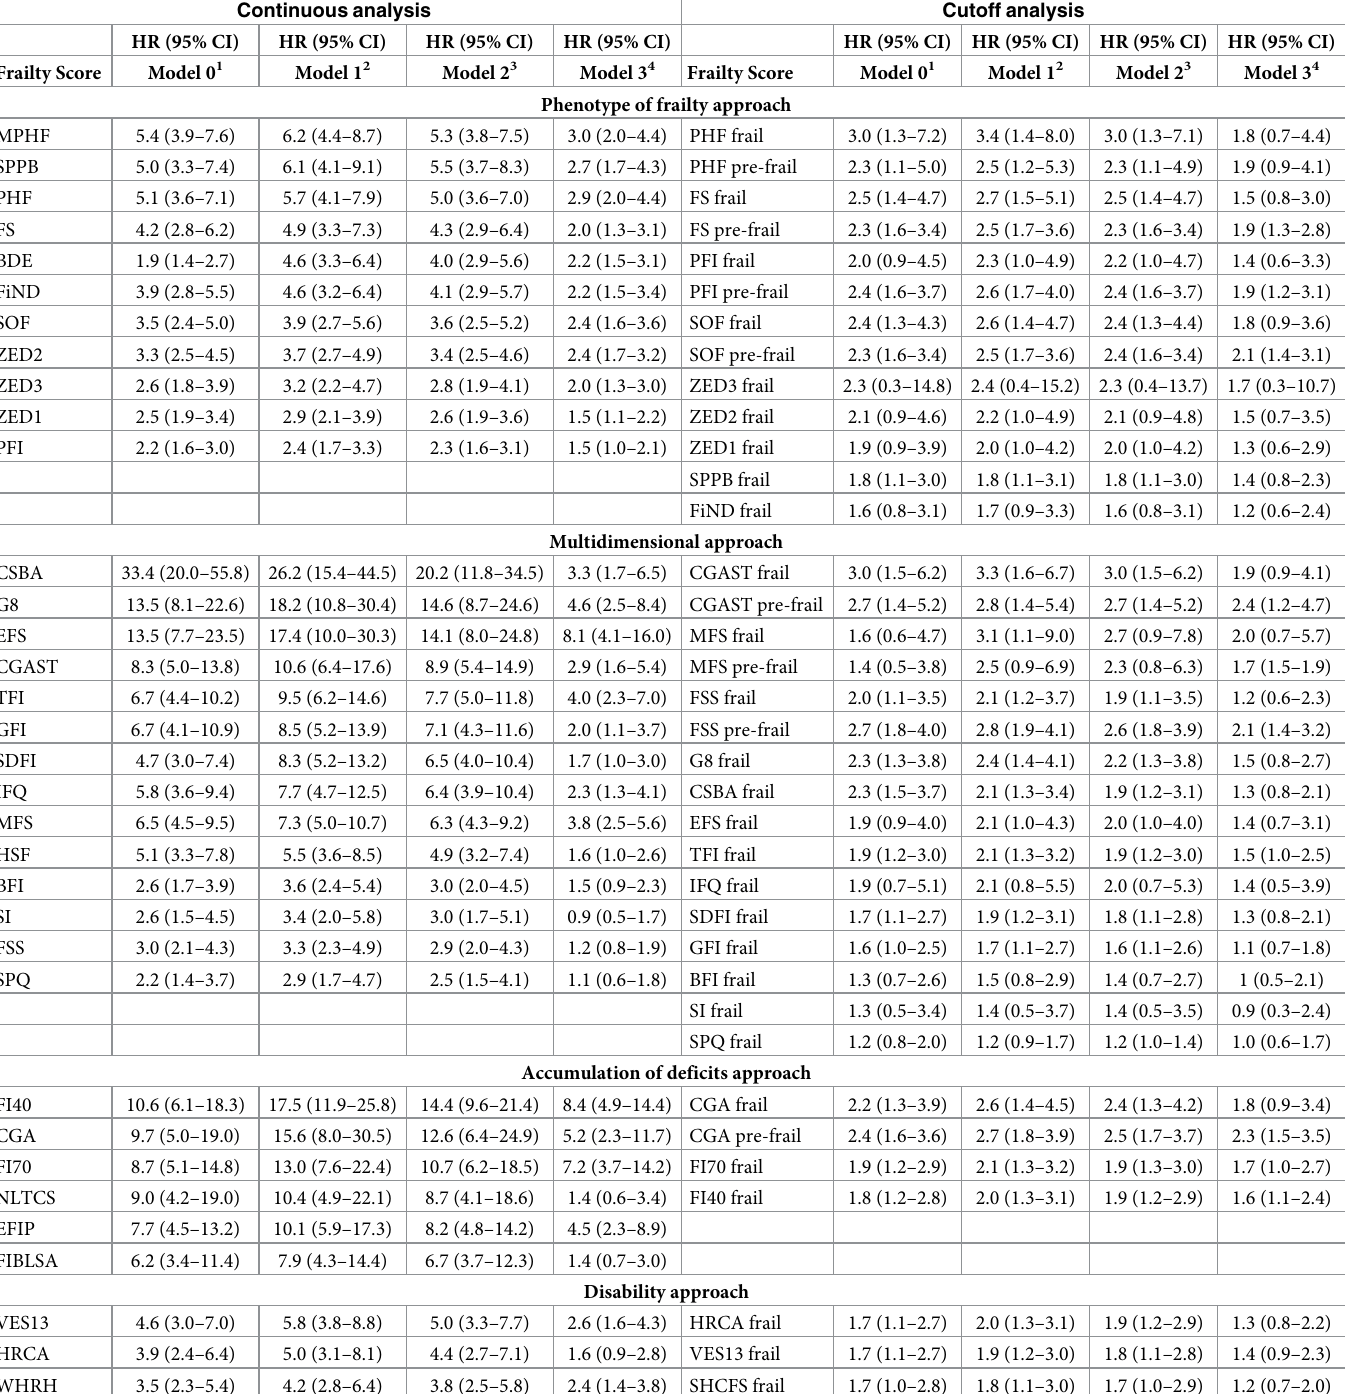
Table 3. Mortality HRs of frailty scores ( n = 5,294) calculated at median time follow-up (3.5 years). Continuous